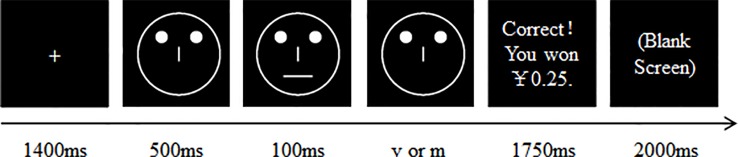
The time course for a single trial. For each trial, the participant was asked to decide whether a short or a long mouth (or nose) was presented by pressing either the ‘v’ or the ‘m’ key of a PC keyboard. The version of the PRT used, the rich stimulus type, and the keyboard keys mapped to the rich and lean stimuli were counterbalanced among the participants.